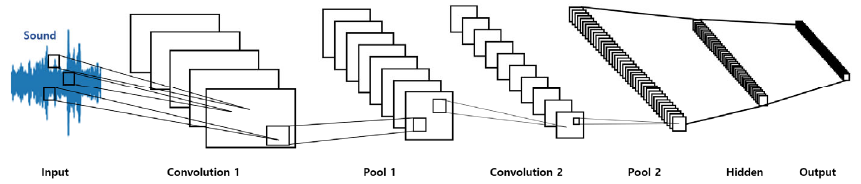
Figure 8. Convolution neural network